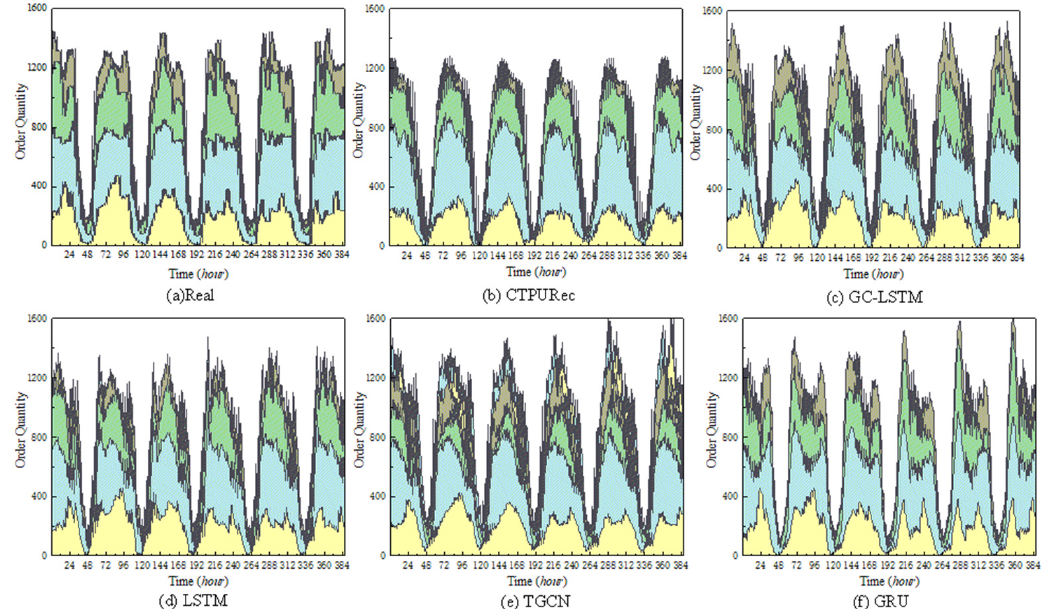
Figure 8. Comparison of the next 16 h prediction effect of different models on the order quantity. ( a ) is the real order quantity. ( b – f ) are the predicted values of the CTPURec, GC-LSTM, LSTM, TGCN and GRU, respectively.